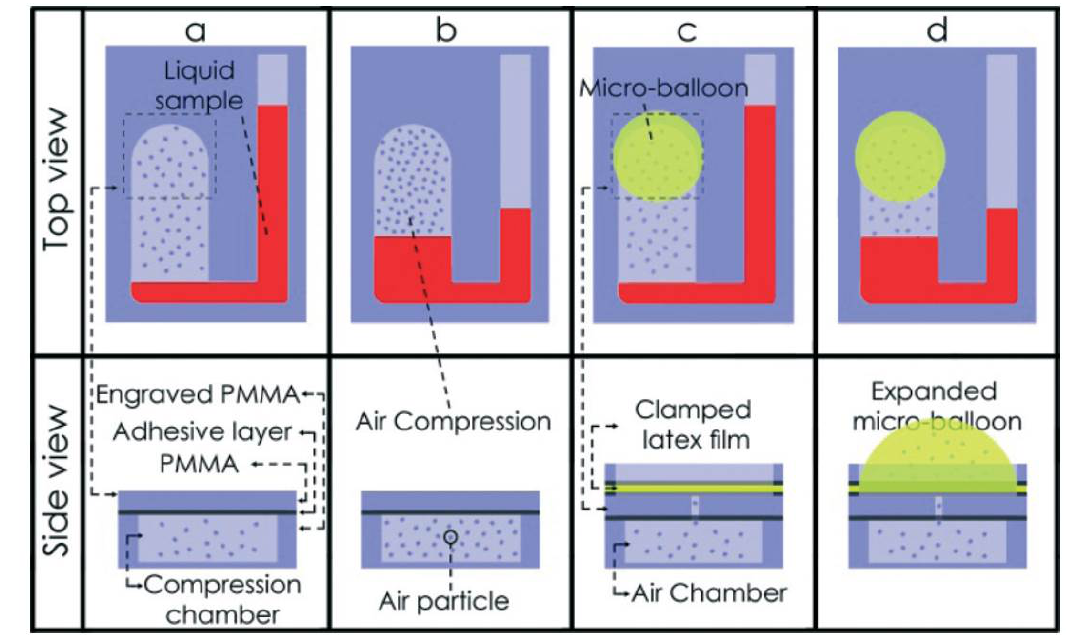
Figure 5. Example of using micro-balloons as flexible walls for effective pneumatic siphon valving in centrifugal microfluidics using lower spin speeds. A comparison is given between standard pneumatic pumping ( a , b ) and pneumatic pumping with the micro-balloon ( c , d ). The micro-balloon implementation (c,d) requires a much lower angular velocity than the standard implementation (a,b), which has a higher air pressure at high centrifugal forces. Reproduced from [68] with permission of The Royal Society of